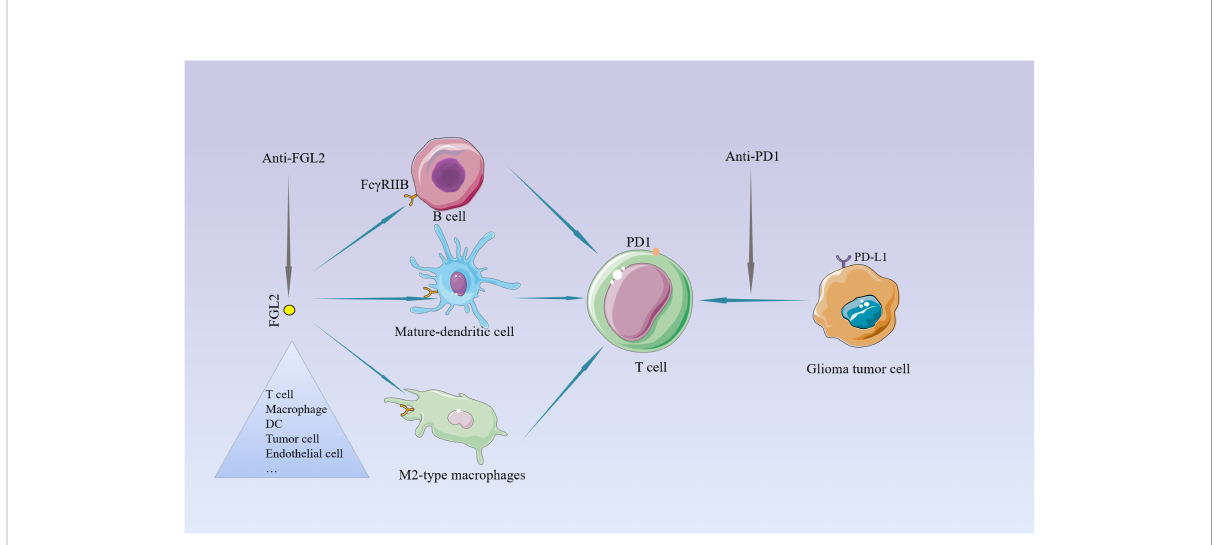
FIGURE 4 The potential for targeting FGL2. Unlike PD1 on T cells, FGL2 primarily targets the APC. PD-1 induces FGL2 expression by inhibiting IFN- g and TNF- a